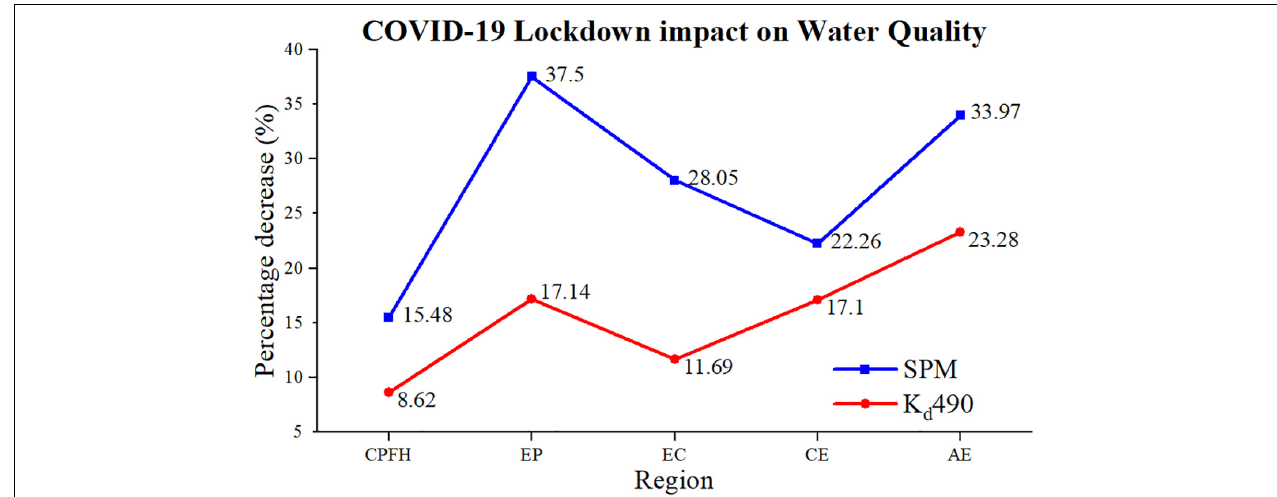
FIGURE 7 | Plot representing positive relationship between SPM and K d